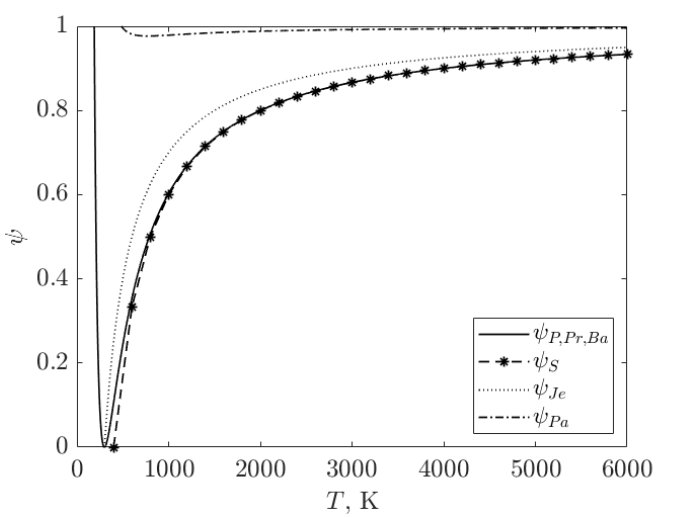
Figure 4. Comparison of the radiation exergy for Petela, Press, Badescu, Spanner, Jeter and Parrott assuming T 2 = 300K, f H = 1 and δ =